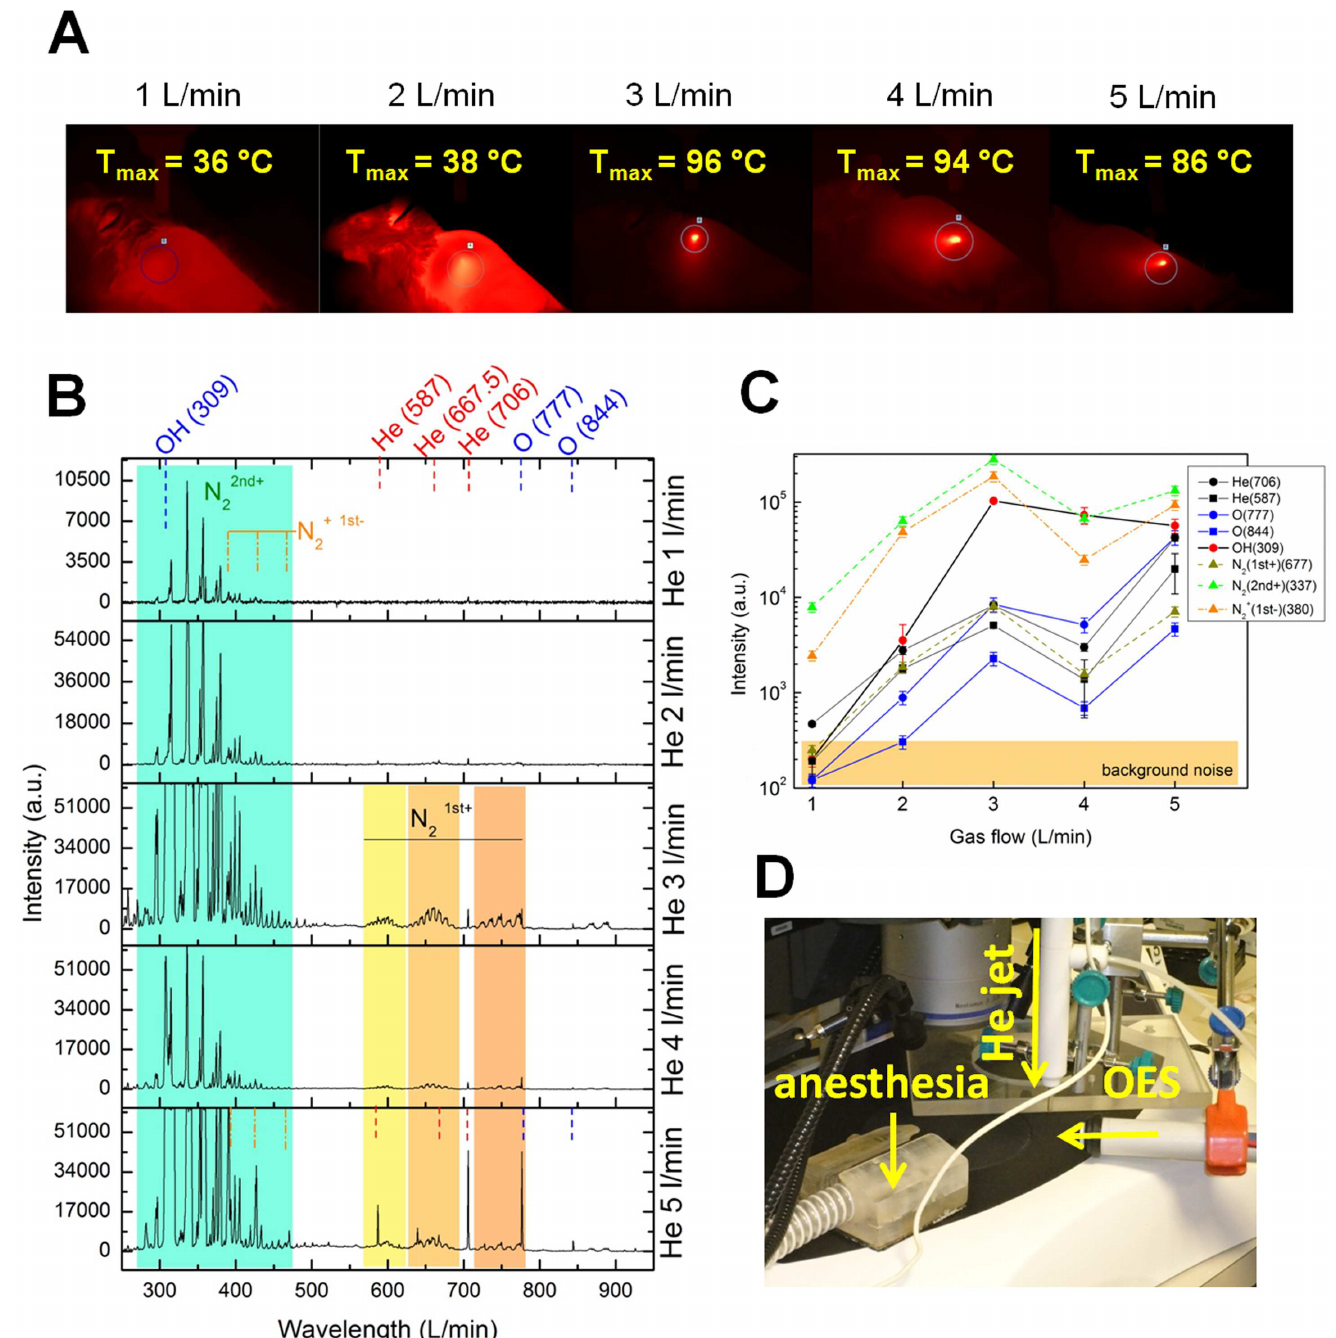
Fig 5. The effect of temperature and gaseous RONS formation on skin damage. A) The surface temperature was measuredon the mouse skin duringthe plasma treatment using IR camera. Mice were treated under different flow rate conditions. The maximum temperature caused by plasma treatment is indicatedon each image. B) OES spectrum of RONS generated in plasma flow duringthe skin treatment at the treatment site. C) Intensity of different RONS, measuredunder different flow rate parameters. D) Combined experimental setup for the purposes of OES measurements. The mice were placedunder helium (He) jet and were anesthetized duringthe procedure. The spectrometer was placedperpendicular to He plasma jet, directed to the treated skin area.